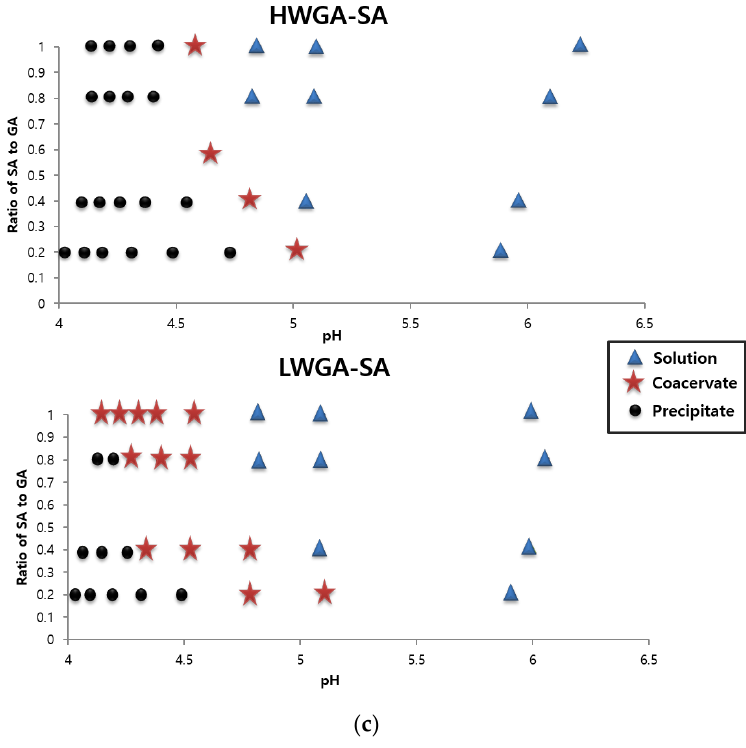
Figure 1. Comparison of complex phases among reaction conditions using high molecular weight gelatin Type A (HWGA) and low molecular weight GA (LWGA). ( a ) Macroscopic appearance of polymer complex phases of various polymer ratios and reaction pHs. ( b ) Representative images of phase contrast light microscopy to compare HWGA-sodium alginate (SA) and LWGA-SA. (Scale bars = 20 µ m). ( c ) Phase diagrams of HWGA-SA and LWGA-SA as a function of pH and the SA to GA ratio.